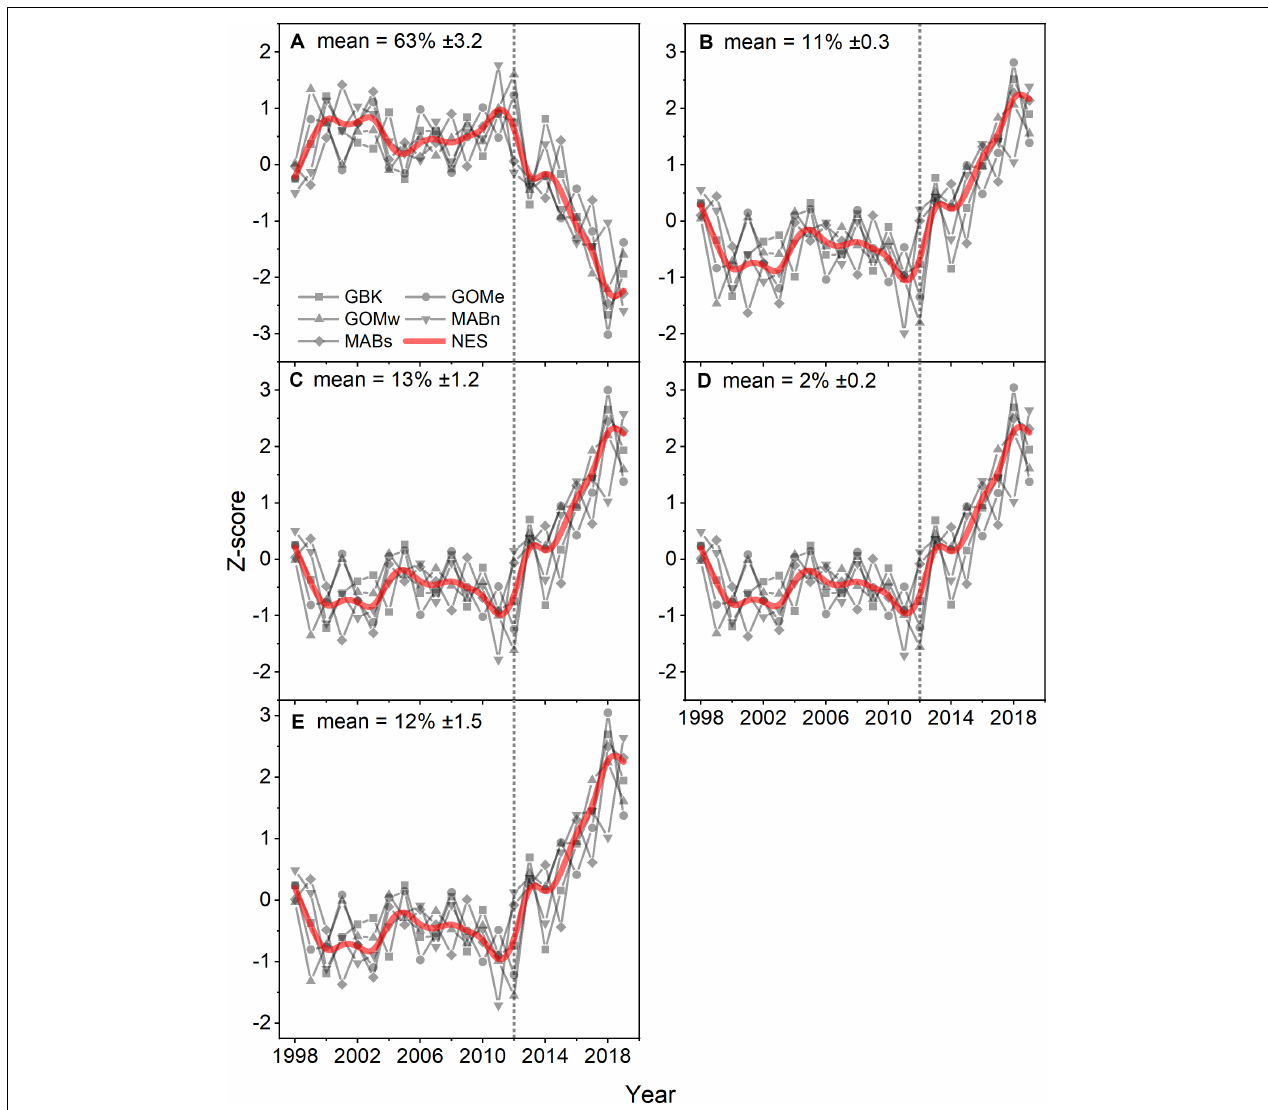
FIGURE 5 | Z-score of estimated percent contribution of PFT diatoms (A) , dinoflagellates (B) , green algae (C) , prymnesiophytes (D) , and prokaryotes (E) for the Northeast Shelf (NES) and NES subareas (NES, GBK, GOMe, GOMw, MABn, and MABs). The mean percentage for each PFT shown in the panel title with ± 1 SD; the NES time series is shown as a b-spline; 2012 is highlighted with vertical dotted line.